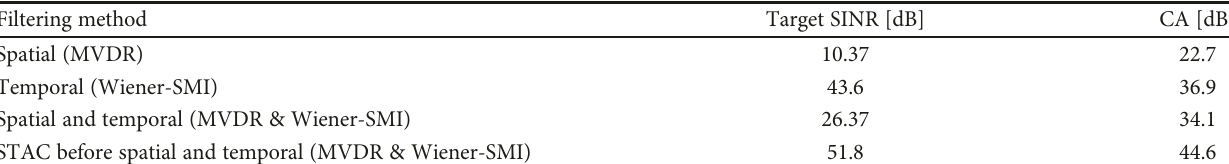
Figure 10: Clutter DOA estimation results for the simulated signal. The dynamic range is 60dB. (a) Clutter DOA estimation on the fi rst 4 range cells. (b) 2D map of the clutter DOA for the fi rst 6 range cells. Table 2: Measured fi lter performances.